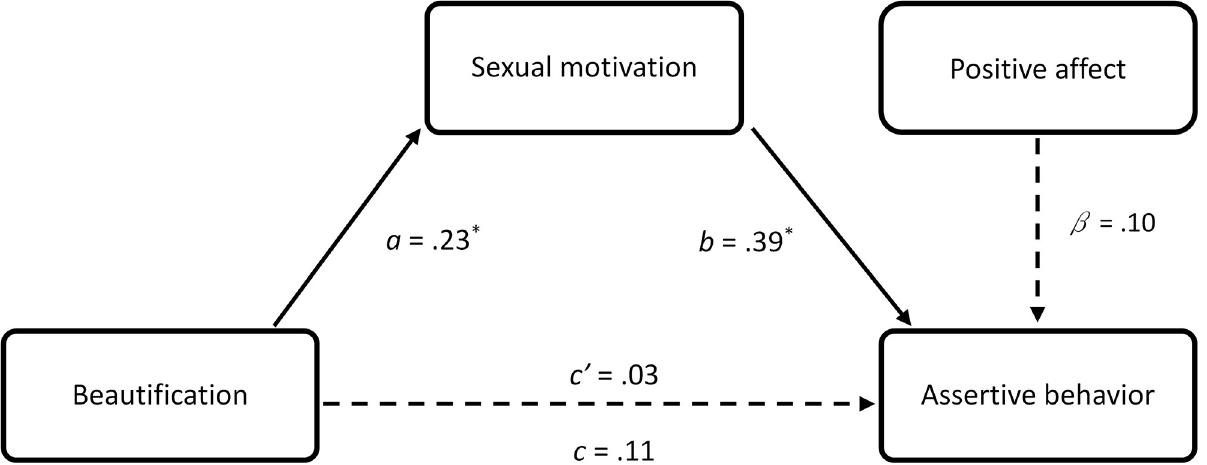
Fig 1. Indirect effect of beautification on assertive behavior in Experiment 1. Note. † p < .10. � p < .05. �� p < .01. ��� p < .001. All coefficients are z - score standardized. Dashed paths are not significant, n = 63.